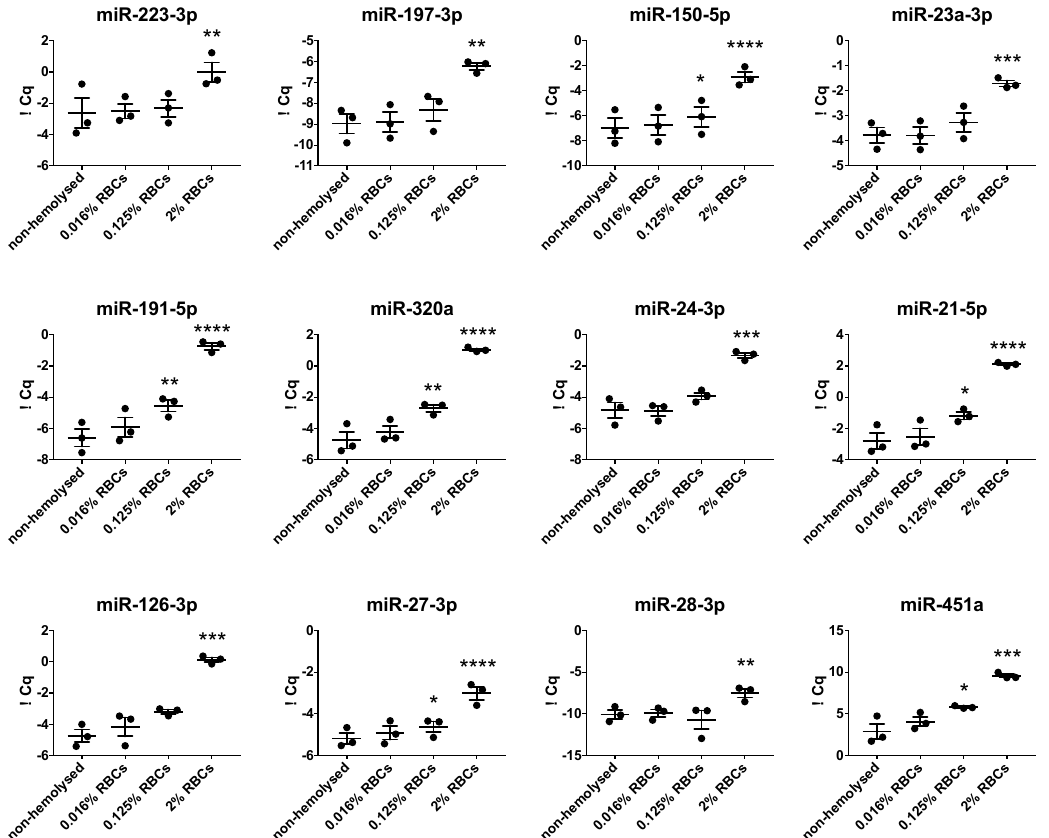
Figure 5. Impact of hemolysis on plasma miRNA levels. Plasma was spiked with red blood cells (RBCs, 0.016%, 0.125% and 2%) and miRNA levels were measured subsequently. Significant differences were determined by one-way ANOVA using Dunnett’s multiple comparison test and were depicted as * p < 0.05, ** p < 0.01, *** p < 0.001, and **** p < 0.0001.